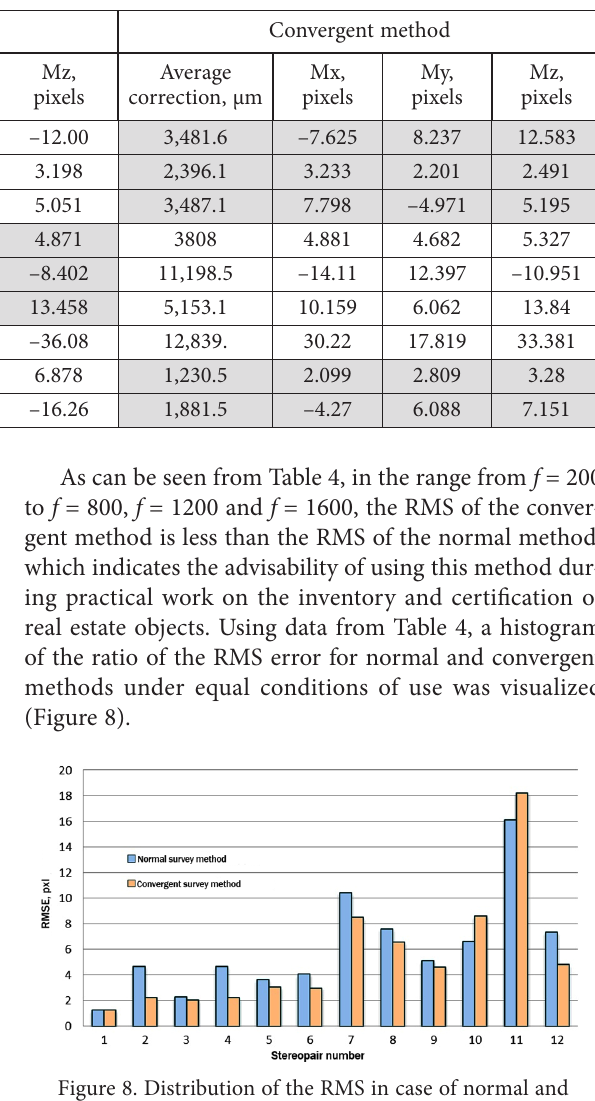
Figure 8. Distribution of the RMS in case of normal and convergent survey